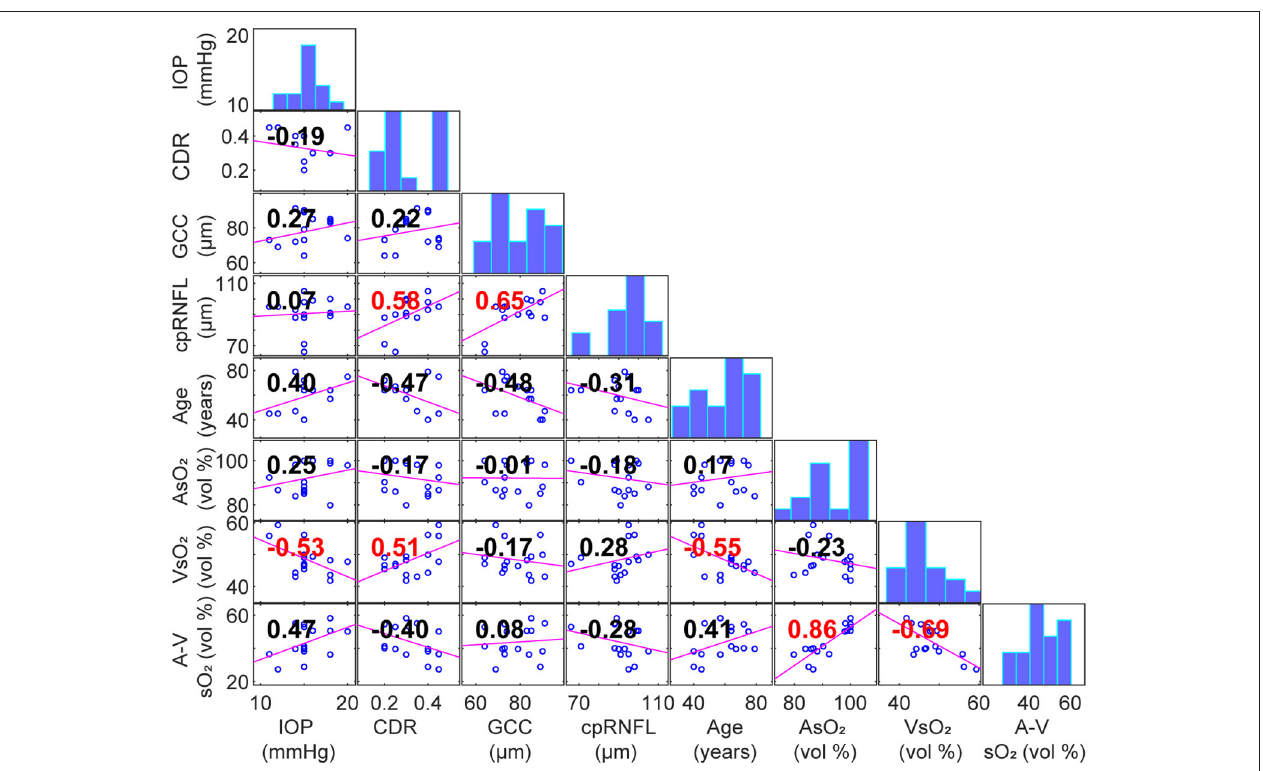
FIGURE 3 | Scatterplot with linear fit for a pair of correlated variables (Panels below the diagonal. Correlation coefficients area labeled in panels. Red: p < 0.05). Diagonal panels are histograms of each variable.